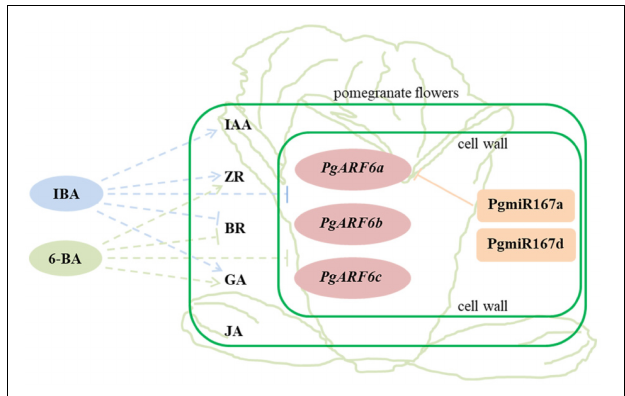
FIGURE 13 | The relationship model for hormones, PgARF6 genes and PgmiR167 in pomegranate flowers development. Solid line represents the direct relationship, dotted line represents the indirect relationship; arrow represents promotion and vertical line represents